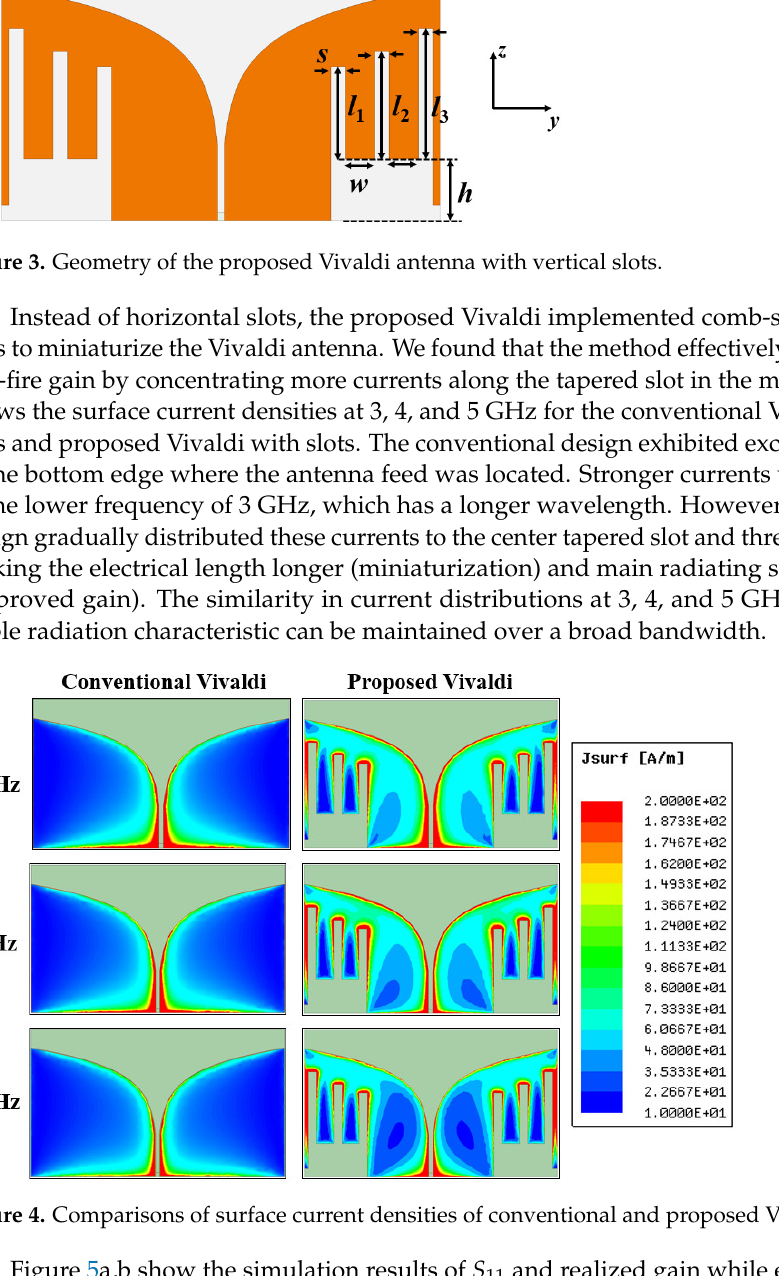
Figure 4. Comparisons of surface current densities of conventional and proposed Vivaldi antennas.